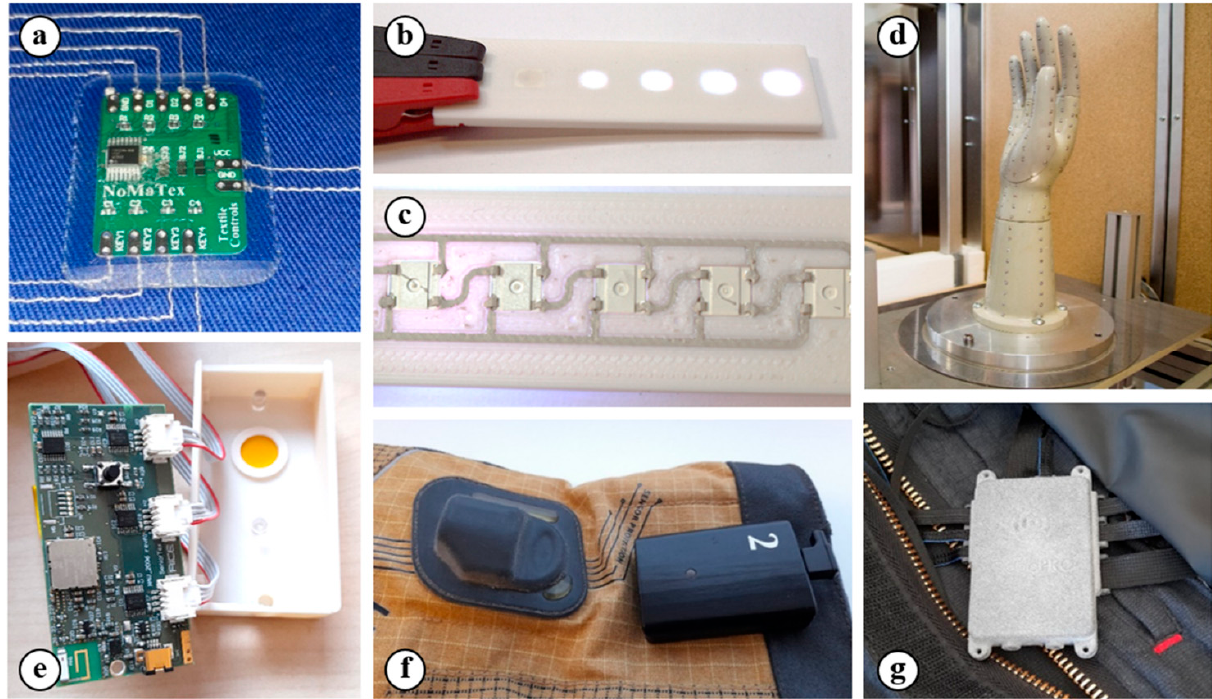
Figure 1. 3D printing in electronic applications: ( a ) a PCB and its encapsulation on a textile substrate by a printed polymer component [2]; ( b , c ) the front and backside views of a printed polymer component with deposited conductive paths and with an incorporated RGB LED component; ( d ) a printed human hand model with 272 temperature sensors for glove testing [33]; ( e ) the housing for wireless communication electronics; ( f ) a smart firefighter glove with 3D printed housing for the battery [34]; and ( g ) a smart firefighter suit with 3D printed housing for the electronics [5] (the practical results of research activities at the workplace of the authors of the study).